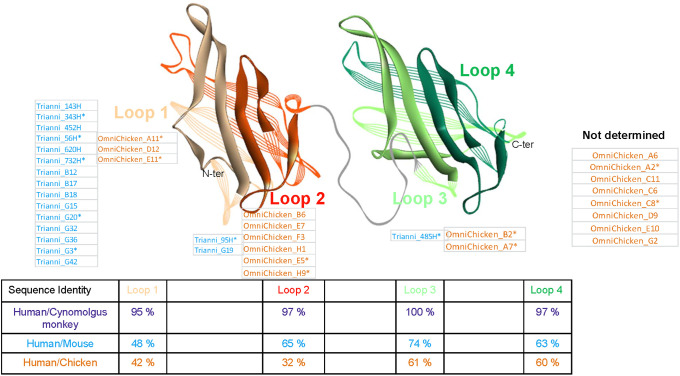
Domain mapping of anti-LAMP1 mAbs.Structure model of the extracellular domain of human LAMP1 with Loop 1 in light brown, Loop 2 in darker brown, Loop 3 in green and Loop 4 in darker green. The names of the anti-LAMP1 mAbs binding to each of the loops are indicted. Table shows the sequence identity to human LAMP1 for each of the four subdomains (loops) of the cynomolgus, murine and chicken LAMP1 homologues. Asterisks (*) indicate mAbs further characterized in the developability study.